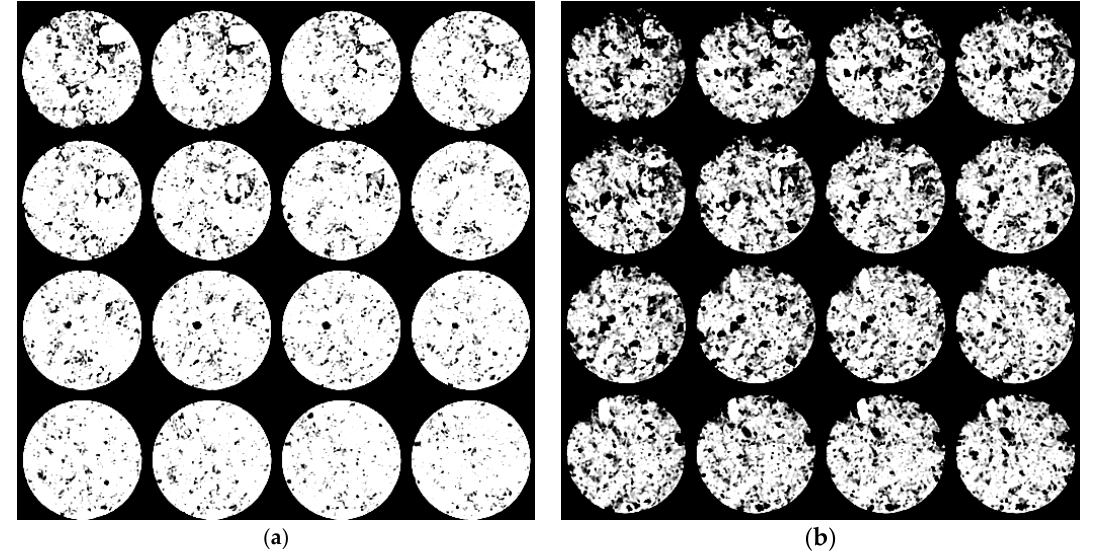
Figure 9. Computed tomography (CT) scan images of a sample, ( a ) fresh; and ( b ) after impregnation for 15 min and exposure for 56 h at 500 °C.